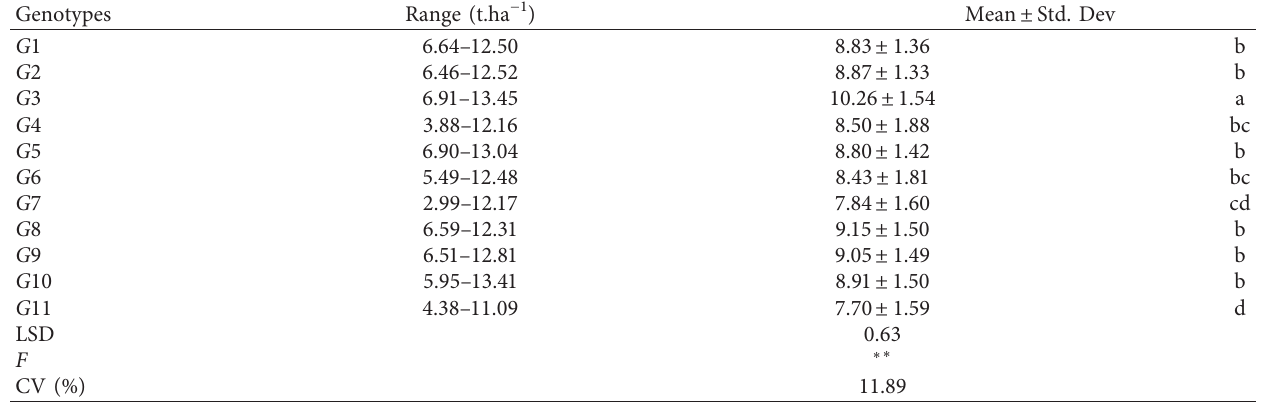
Table 5: Combined analysis of variance of grain yield data of 11 maize